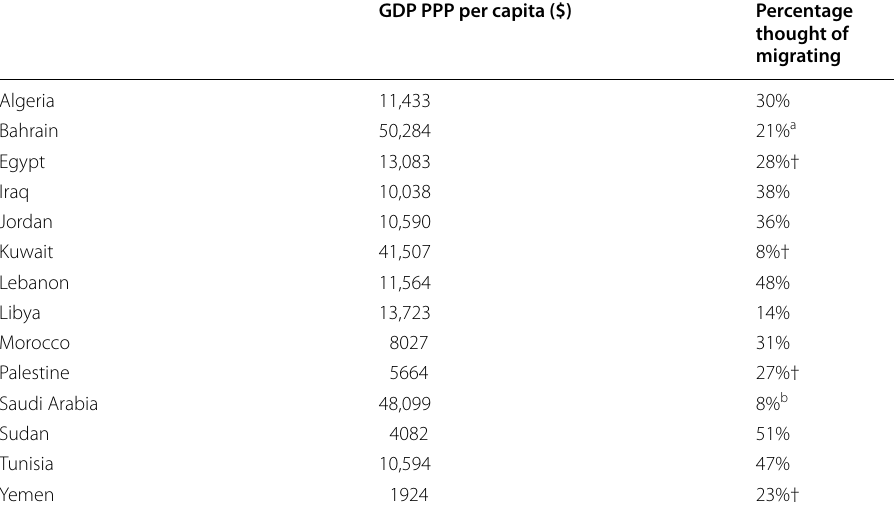
GDP PPP per capita from the IMF (2021); Proportion thought of migrating from the 2021 Arab Barometer, † from 2019 Arab Barometer a Bahrain last surveyed in 2007 and b Saudi Arabia last surveyed in 2011